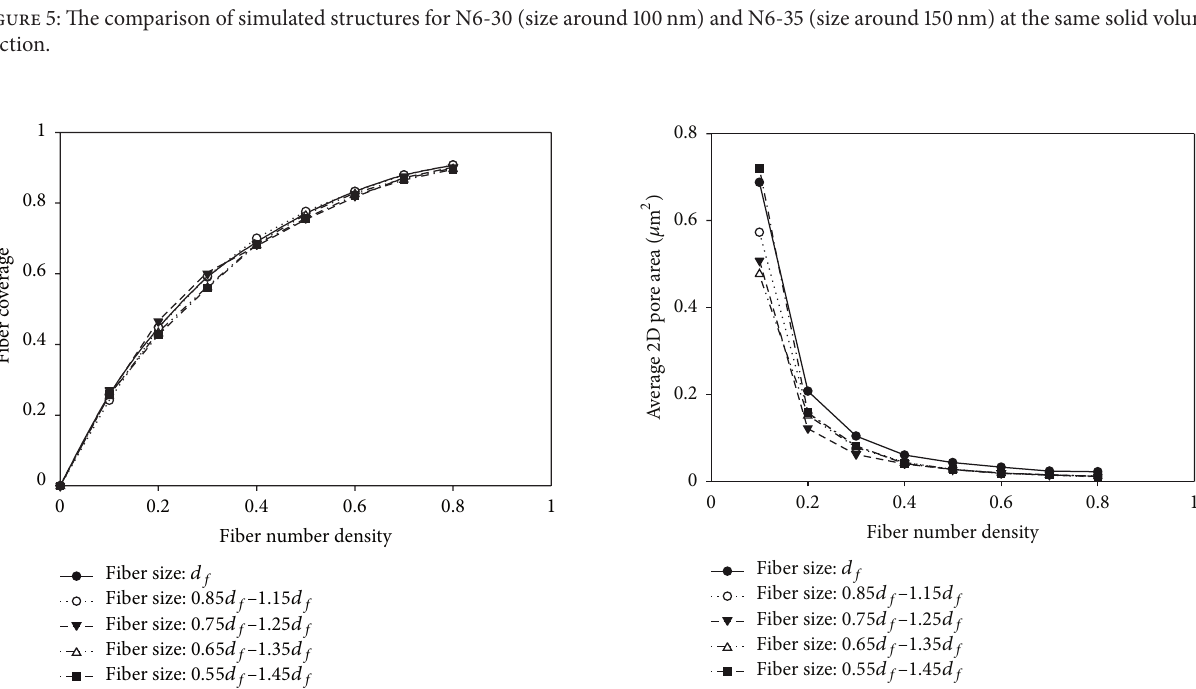
Figure 7: The average projected pore areas in squared micron (as seen in 2D) at different fiber number density. The comparison is for all